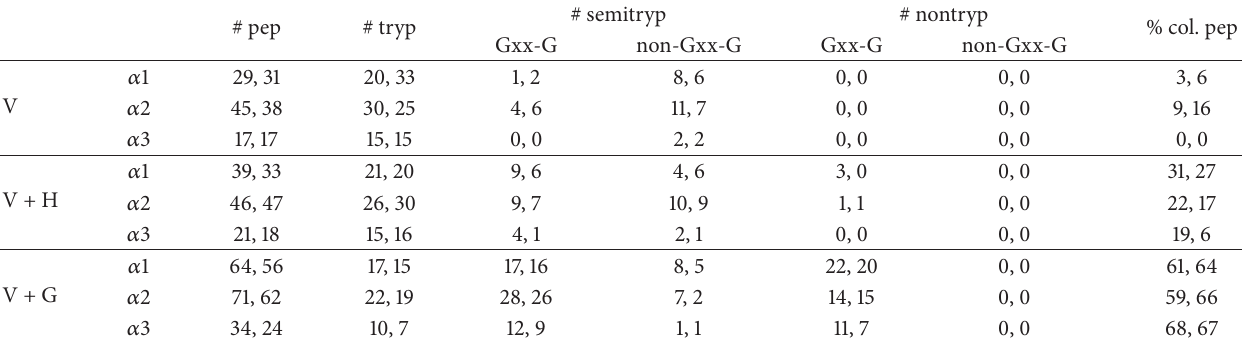
Table 1: Peptide numbers detected by ESI-MS.